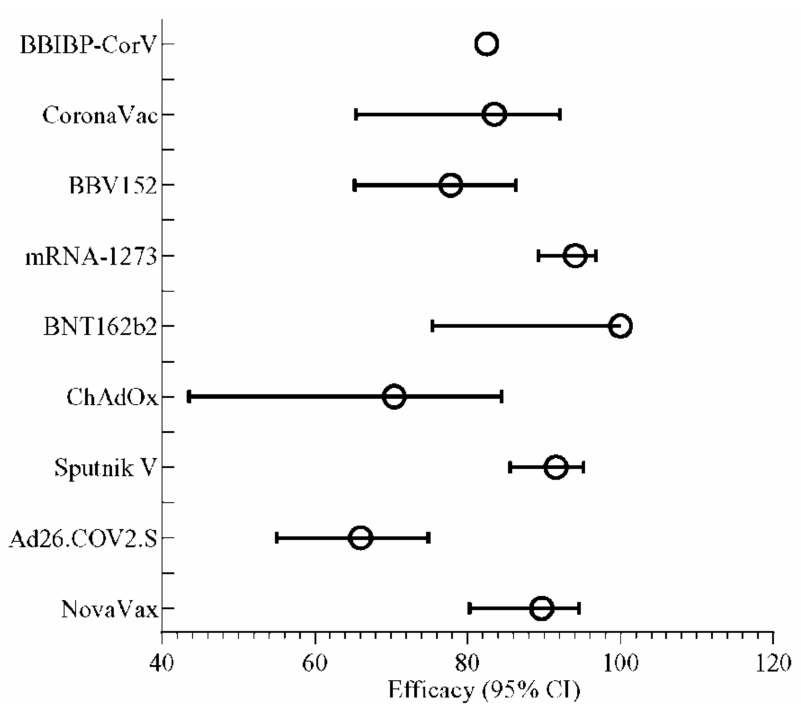
Figure 3. Efficacy of different SARS-CoV-2 vaccine candidates. Here, the small circles imply the reported efficacy after vaccination. All the data were extracted from the included articles, which were selected for this systematic review only. As all the vaccines did not have the same response levels, the 95% CIs were not evenly distributed. For BBIBP-CorV, we were not able to find the upper and lower limits of 95% CI; thus, it was not reported in the